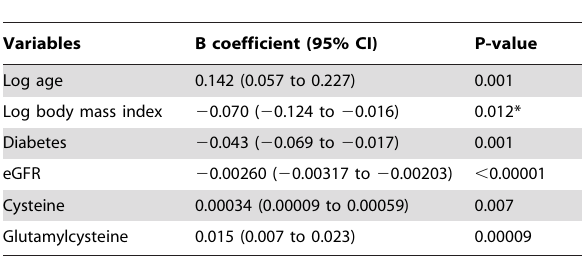
Table 4. Forward stepwise regression of serum SDMA